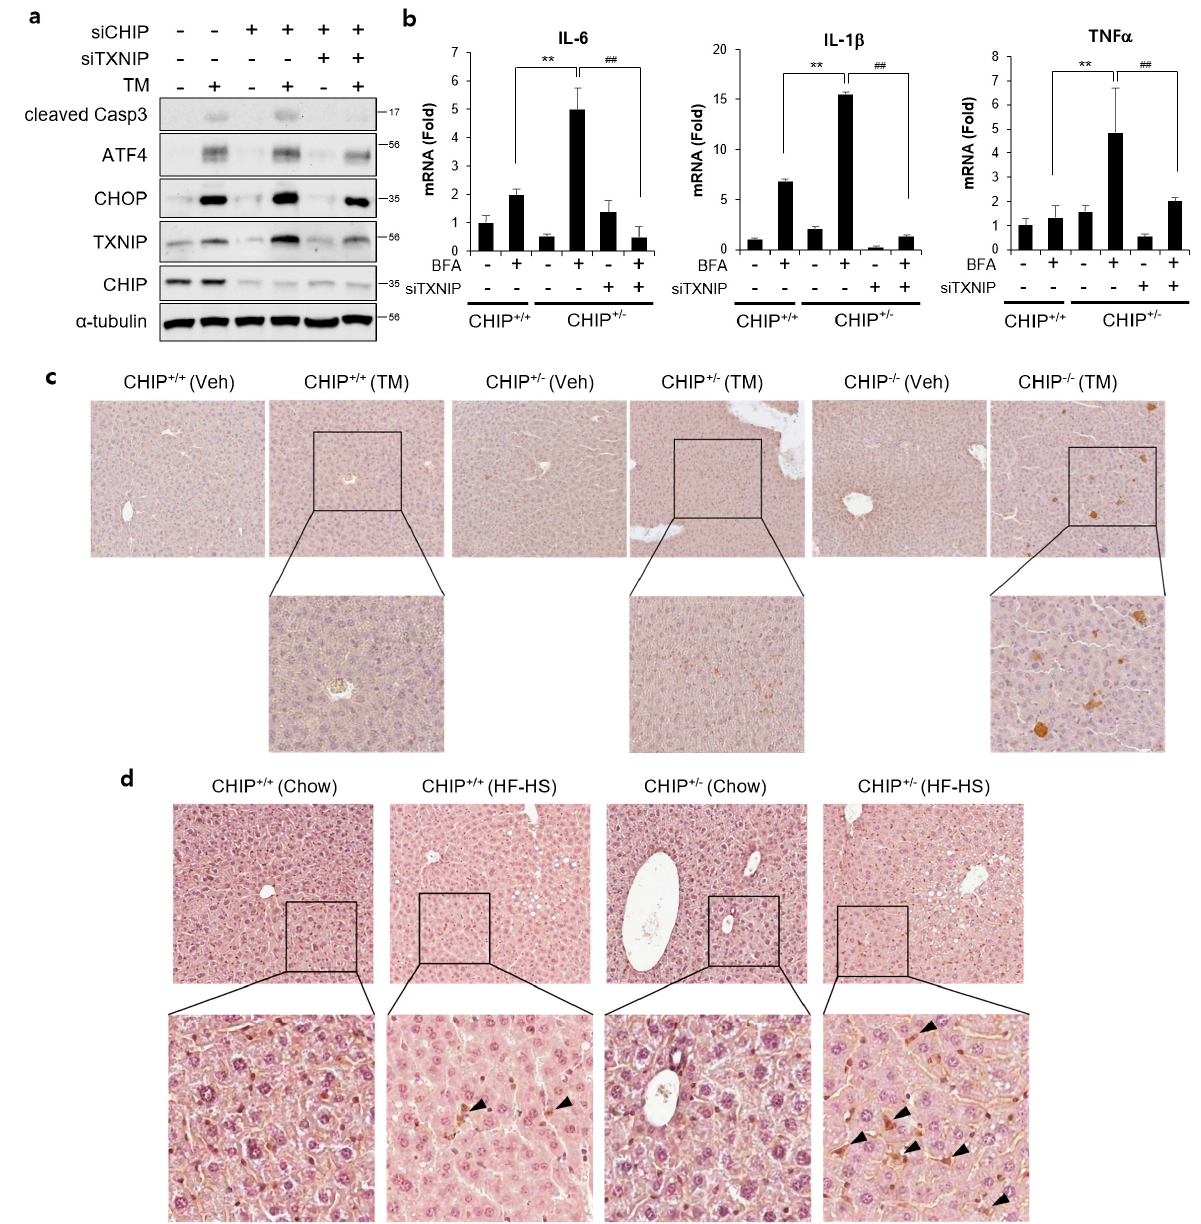
Figure 7. CHIP-mediated TXNIP regulation is responsible for ER stress and inflammatory response.